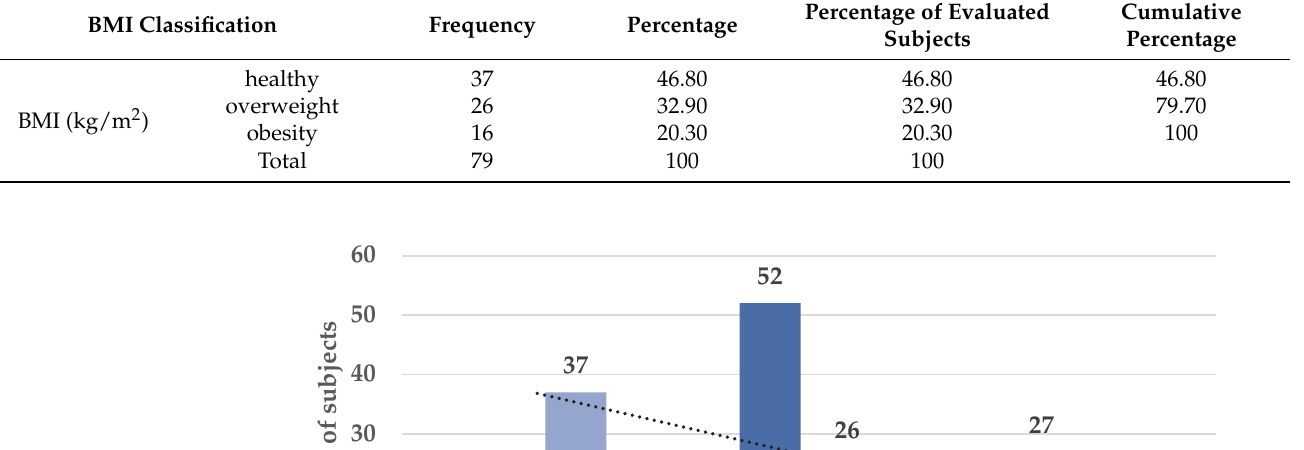
Figure 7. Body mass index distribution in initial and final testing for the target sample.